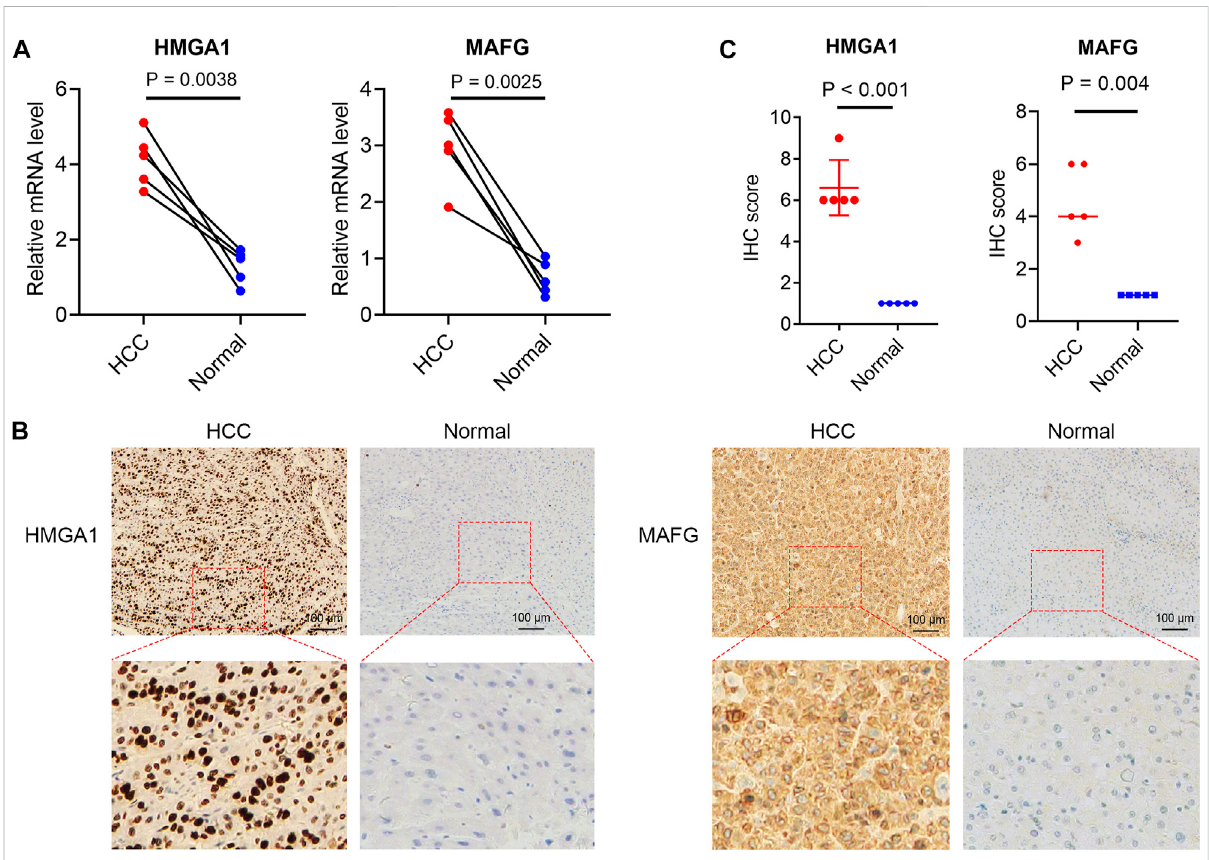
FIGURE 2 Validated expressions of TFs in the TF signature in patient samples (A) The mRNA levels of HMGA1 and MAFG in tumor and adjacent non- tumorous tissues from our cohort. The immunohistochemical staining (B) and statistical signi fi cance (C) of HMGA1 and MAFG in HCC and normal liver tissues from our cohort. TFs, transcription